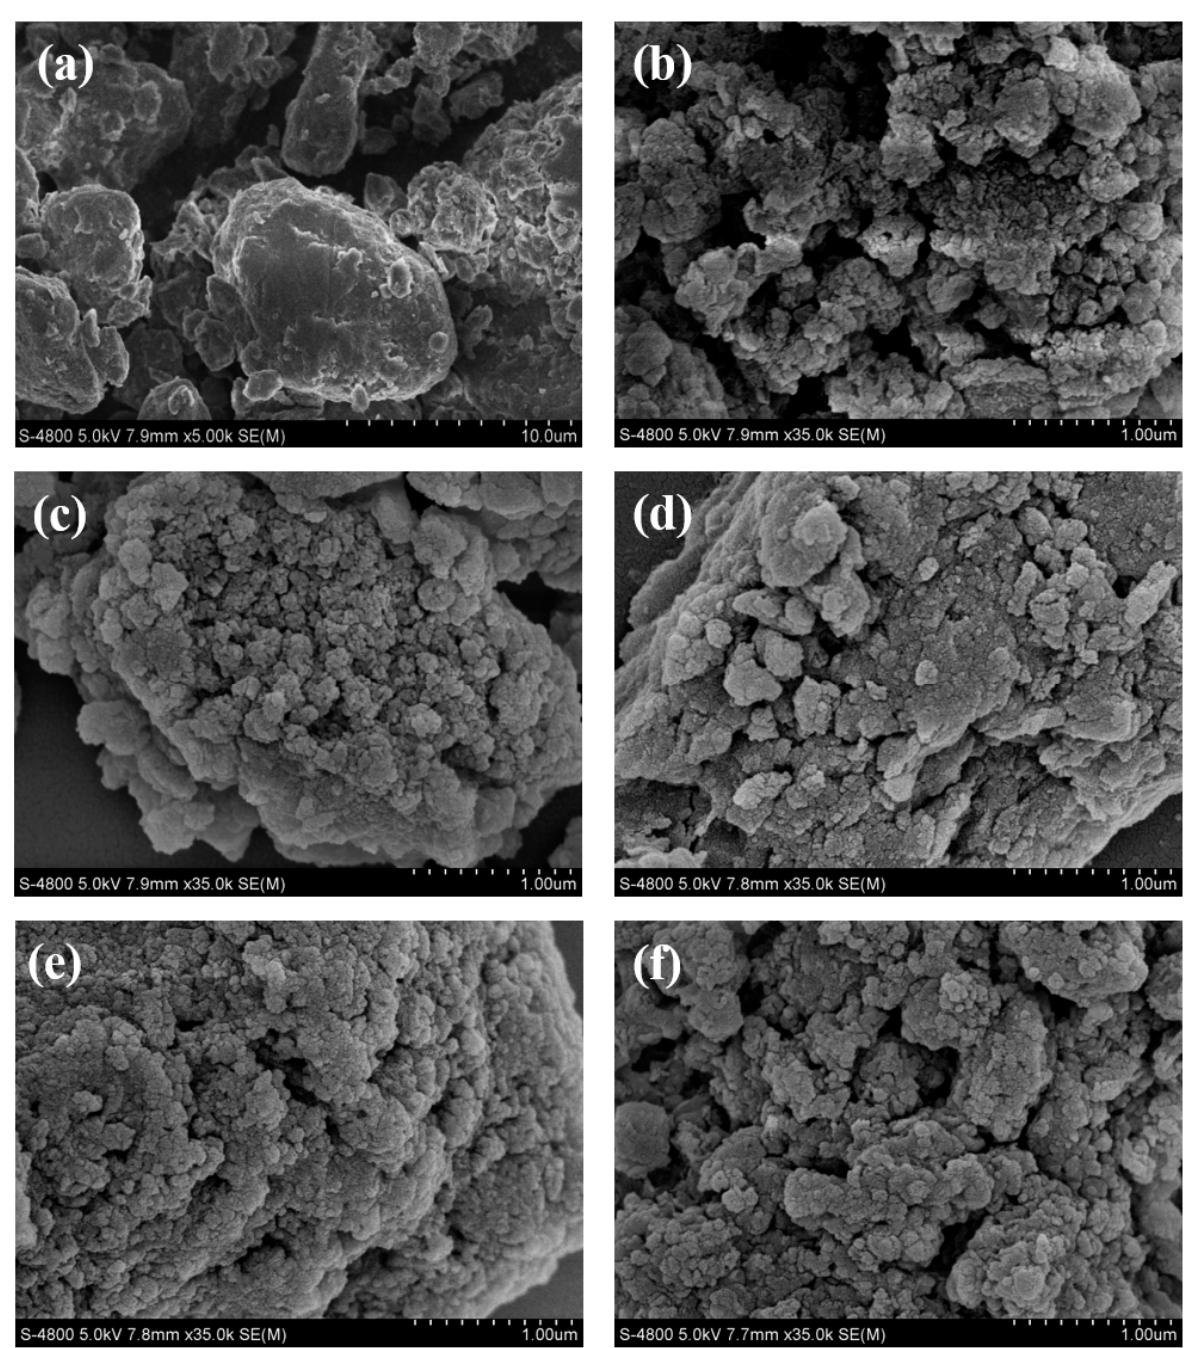
Figure 3. Scanning electron microscopy (SEM) images: ( a ) hectorite, ( b ) TH-1, ( c ) TH-2, ( d ) TH-3, ( e ) TH-4, and ( f ) TH-5.